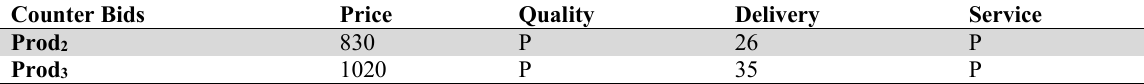
Round 3: counter-bids generated by the Supplier